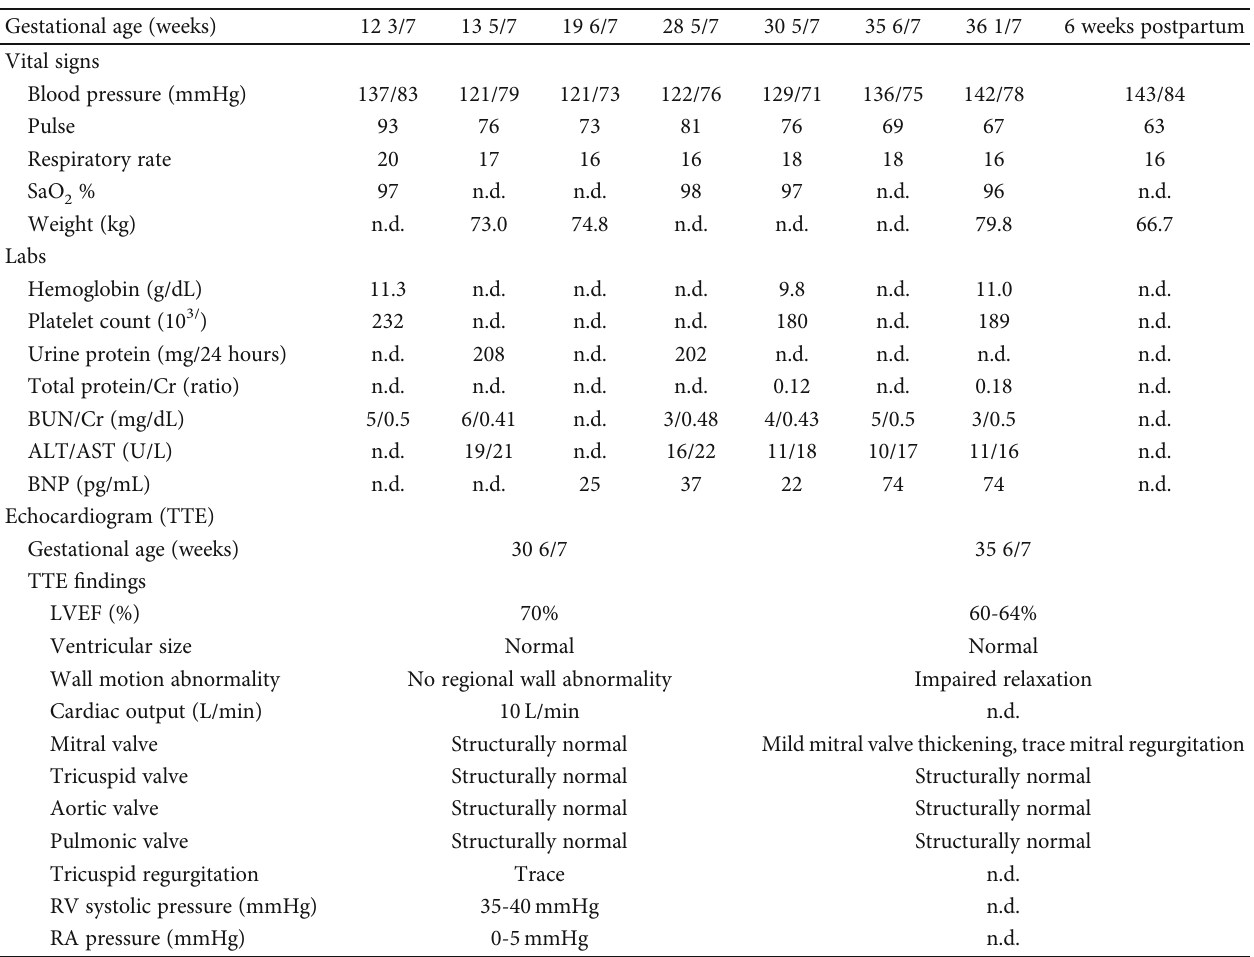
Table 1: Vital signs, echocardiogram fi ndings, and signi fi cant lab values by gestational